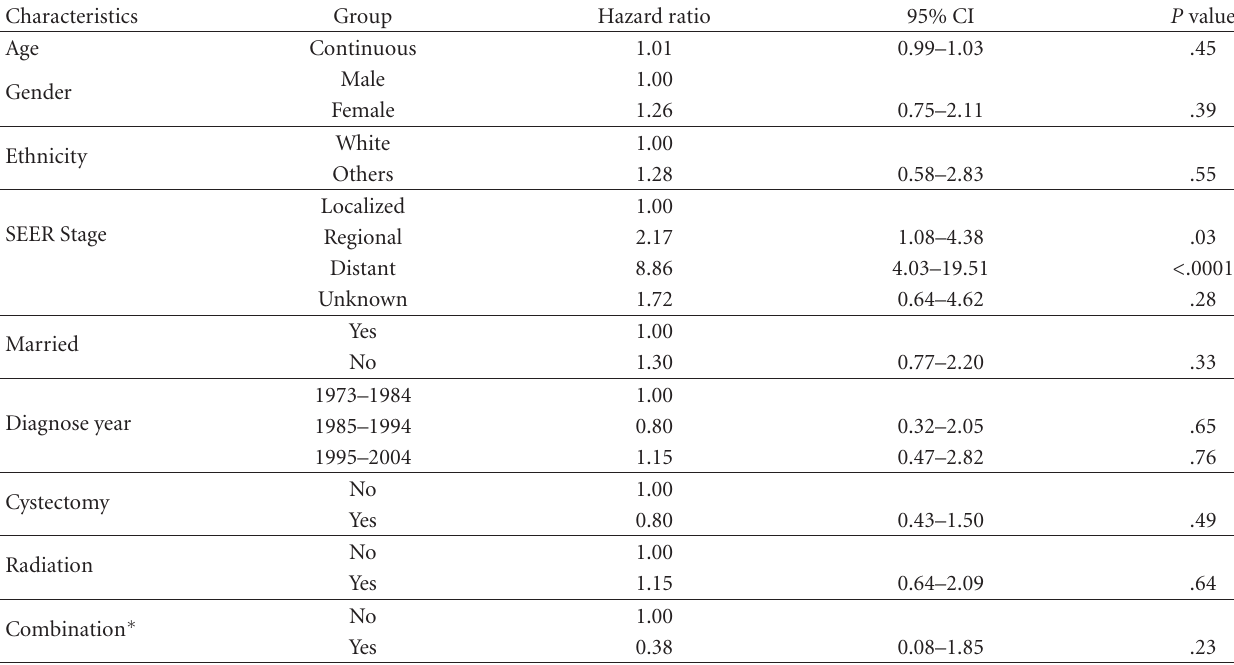
Table 4: COX proportional multivariate analysis of factors associated with sarcomatoid carcinoma (carcinosarcoma) of the urinary bladder disease specific